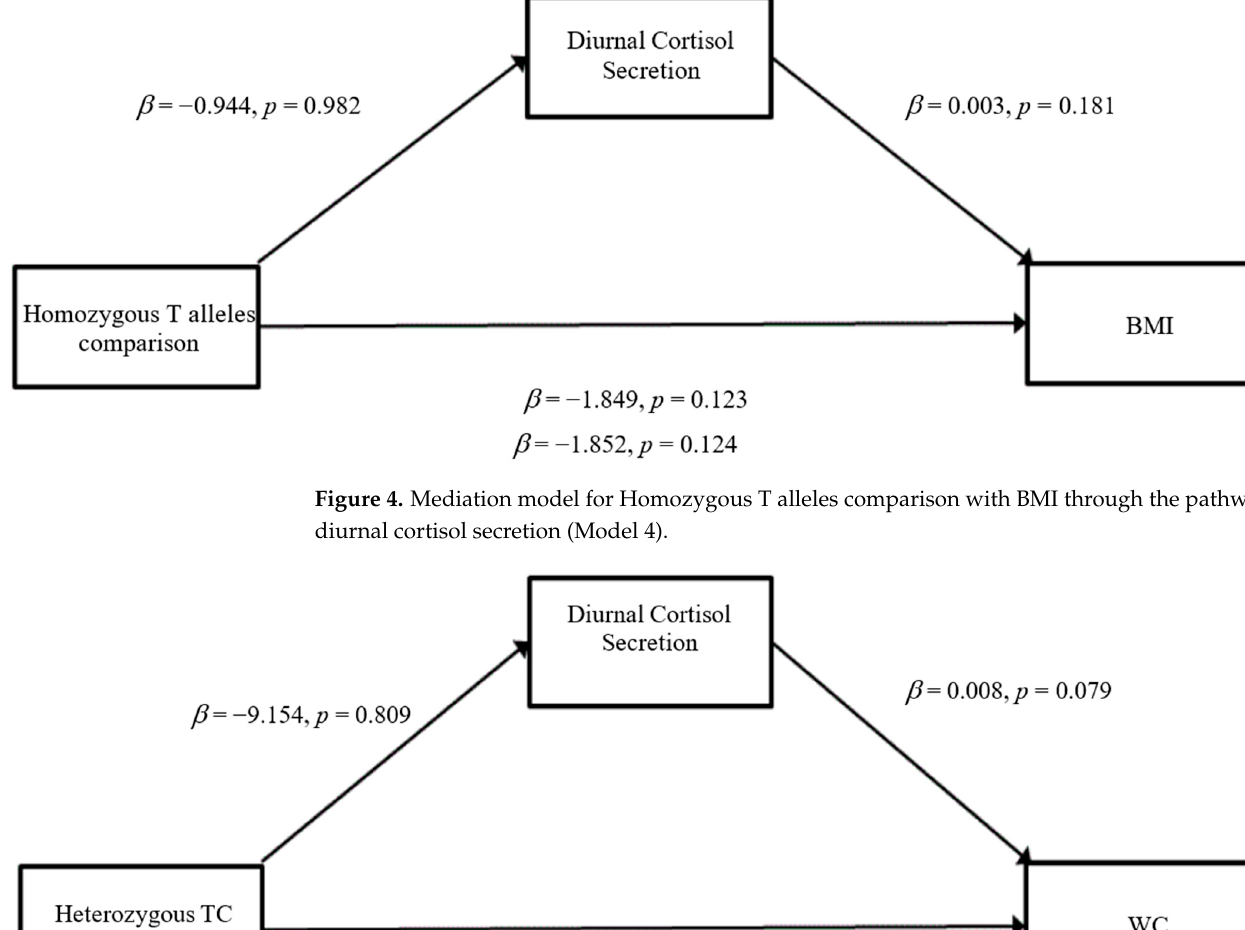
Figure 3. Mediation model for the Heterozygous TC alleles comparison with BMI through the path- way of diurnal cortisol secretion (Model 4).